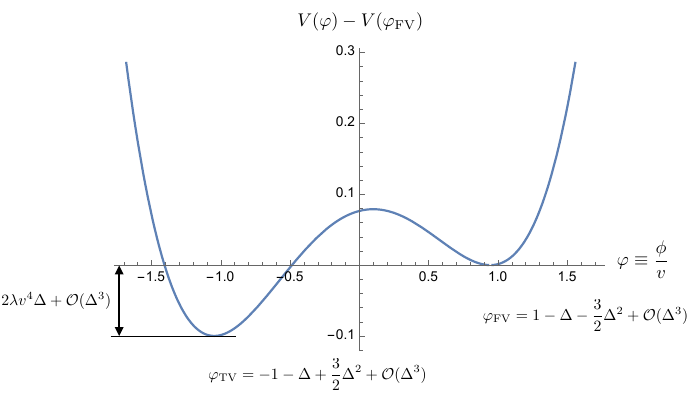
Figure 1 . The potential (2.1) as a function of ϕ ≡ φ/v with V FV subtracted, such that the difference vanishes at the FV. We set λv 4 = 1 , ∆ = 0 . 05 in the plot.